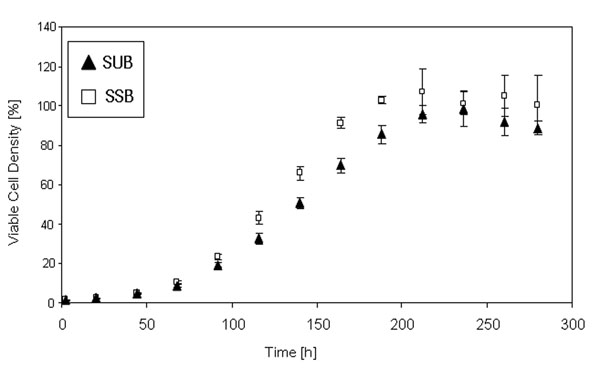
Viable cell density